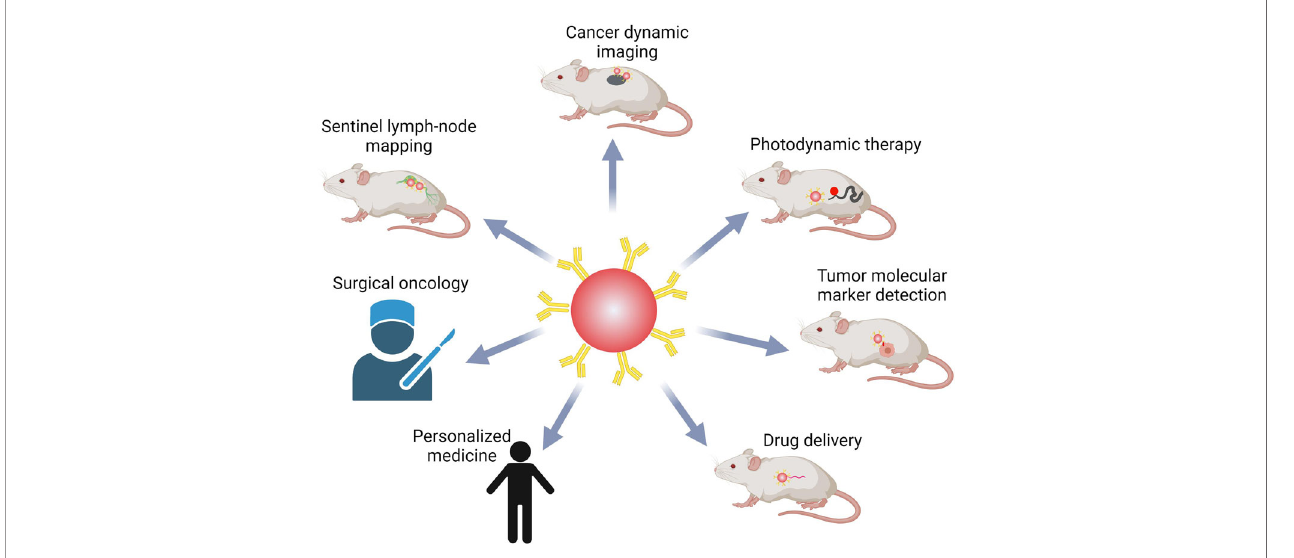
FIGURE 6 | QDs-based probes in bio-imaging, bio-detection, and bio-medicine. QDs are very promising in cancer research and treatment, including real-time systemic imaging, minimal side effects, photodynamic therapy, detection of multiple biomarkers, and delivering drugs. QDs might also help with surgical oncology and individualized precision